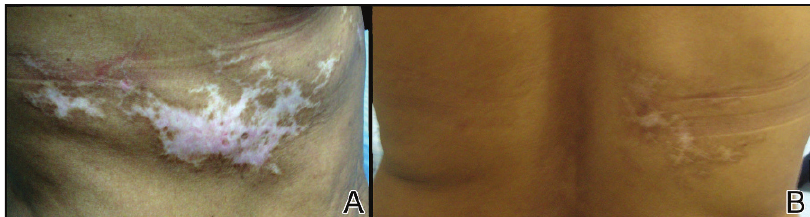
Figure 3 - A) Hypochromic scars after herpes zoster on the thoracic region along the intercostal nerve path. B) Hypochromic scars after herpes zoster on the thoracic region along the intercostal nerve path –